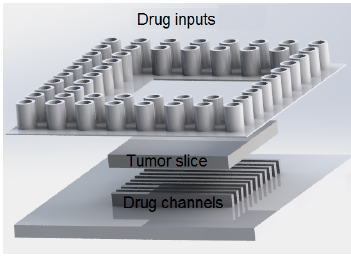
Figure 10. Schematic representation of the system used to assay the response of tumor slice to an anticancer drug (temozolomide). Reproduced after [91].